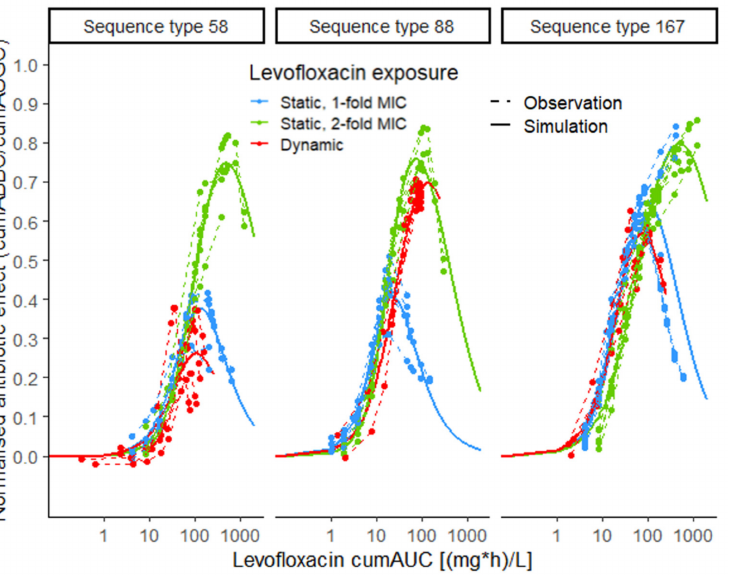
Figure 2. Exposure–effect relationship of levofloxacin against Escherichia coli in static and dy- namic in vitro infection model experiments, stratified per exposure pattern (blue: static, 1-fold MIC; green: static, 2-fold MIC; red: dynamic); exposure metric: cumulative area under the levofloxacin- concentration–time profile (cumAUC(t)); effect metric: cumulative area between the growth-control and the bacterial-killing and -regrowth curve (cumABBC(t)), normalised to the area under the growth- control curve (cumAUGC(t)); observations (points and dashed lines) and deterministic simulations (solid lines) based on the E max model with inhibition term; MIC: minimal inhibitory concentration.